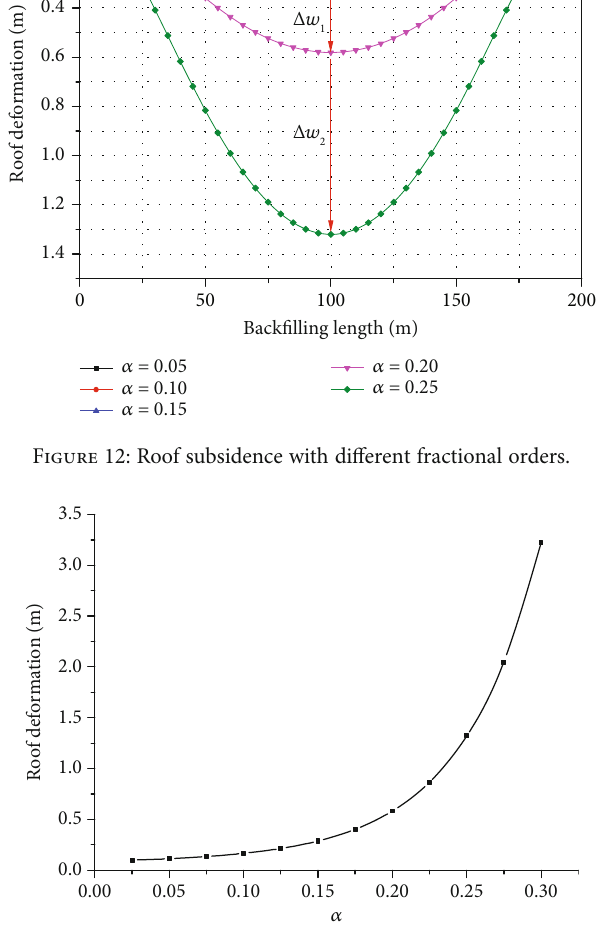
Figure 13: Relationship of maximum roof subsidence and fractional